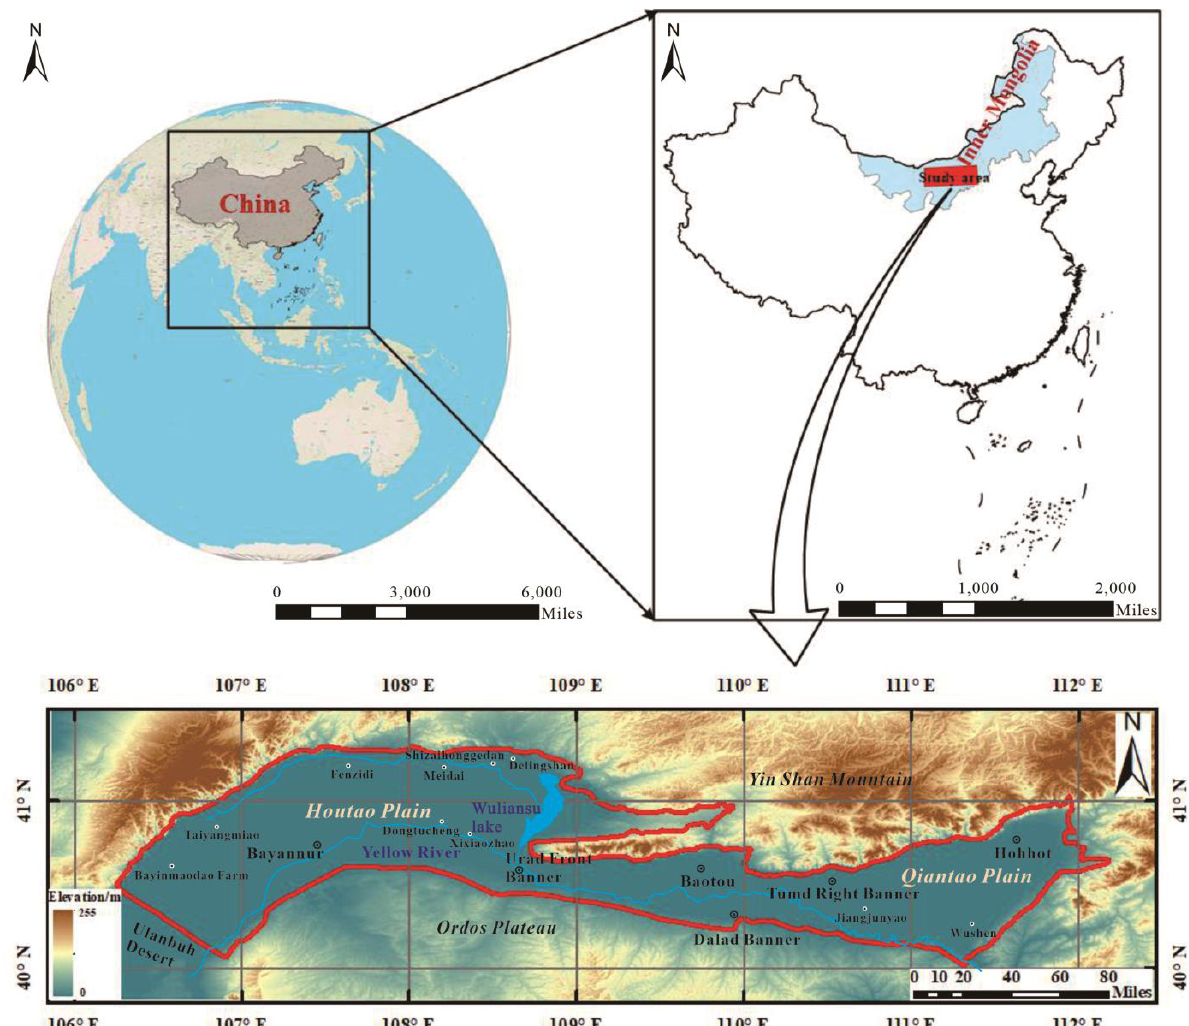
Figure 1. Geographic location and digital elevation model (DEM) of the Hetao Plain.